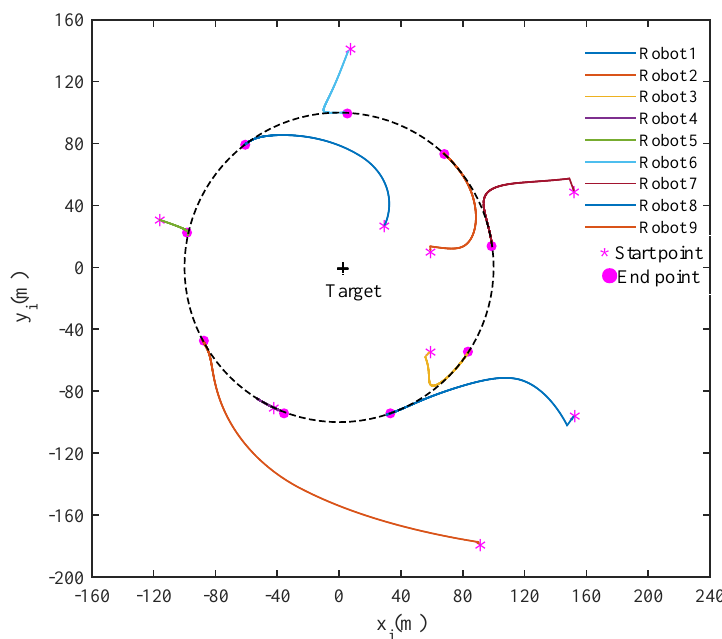
Figure 3. Trajectories of nine robots on the plane at t ∈ ( 0,10 ] when k r = 1 and k θ =